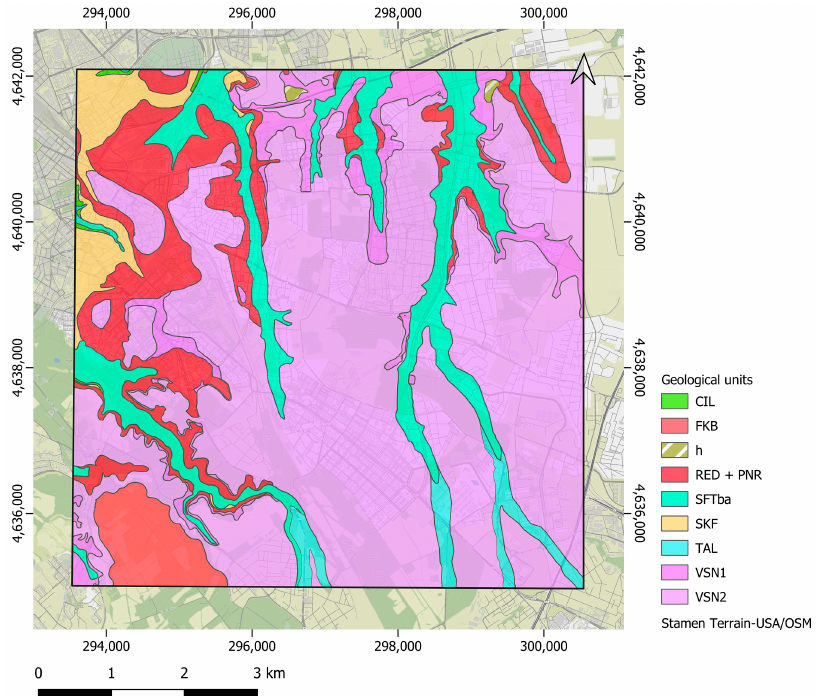
Figure 2. Vectorization of geological units from the Carta Geologica del Comune di Roma, 1:50,000 [51], validated with the Carta Idrogeologica dell’area di Roma, 1:50,000 [52]. Geological Units: CIL (S. Cecilia Formation—conglomerate/sands/silts); FKB (formation of Madonna degli Angeli—Lava lithofacies); RED + PNR (red and black pozzolana); SFTba (silty-sandy and silty-clayey deposits), SKF (pyroclastic deposits); TAL (sequences of gravelly sandy deposits/volcanic elements); h (historical deposits) VSN1(formation of Villa Senni—Tufo Lionato); VSN2 (formation of Villa